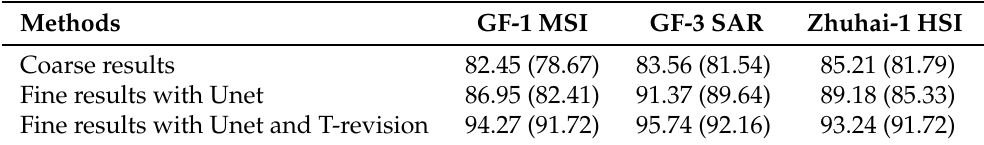
Table 3. OA and kappa (%) of fine water extraction results.